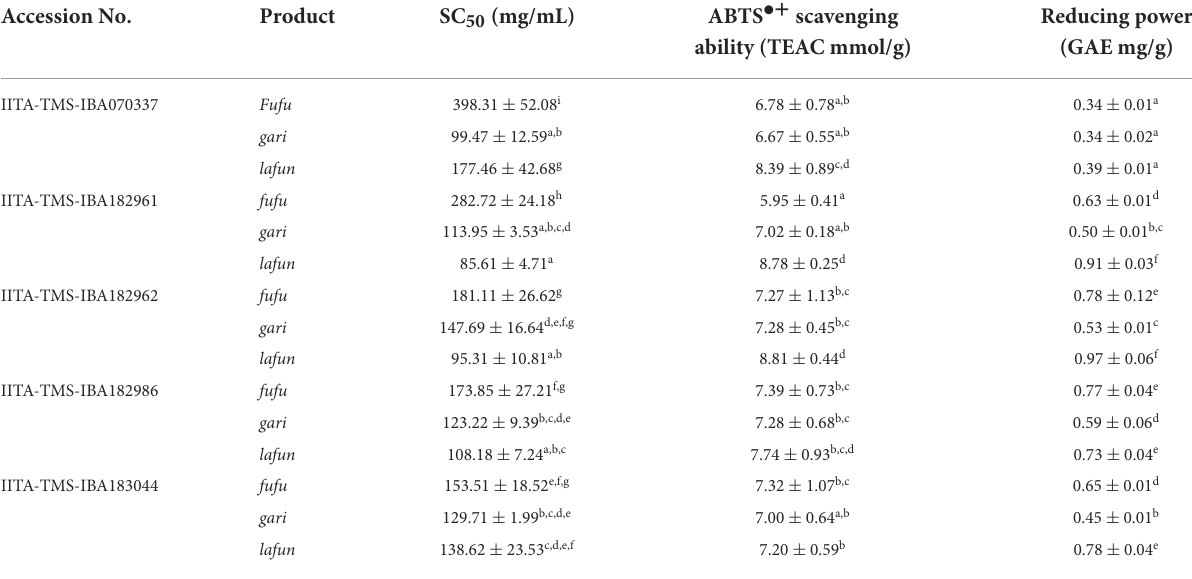
TABLE 2 Antioxidant activity of fufu, lafun and gari from five provitamin A biofortified yellow-fleshed cassava genotypes. Accession